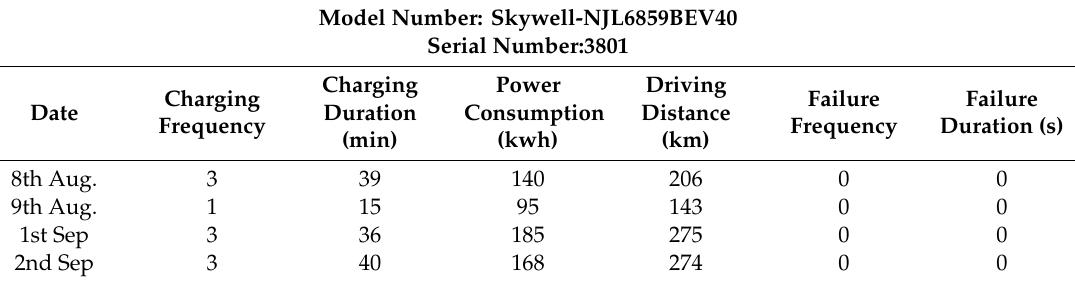
Table 4. Example of Data Collection